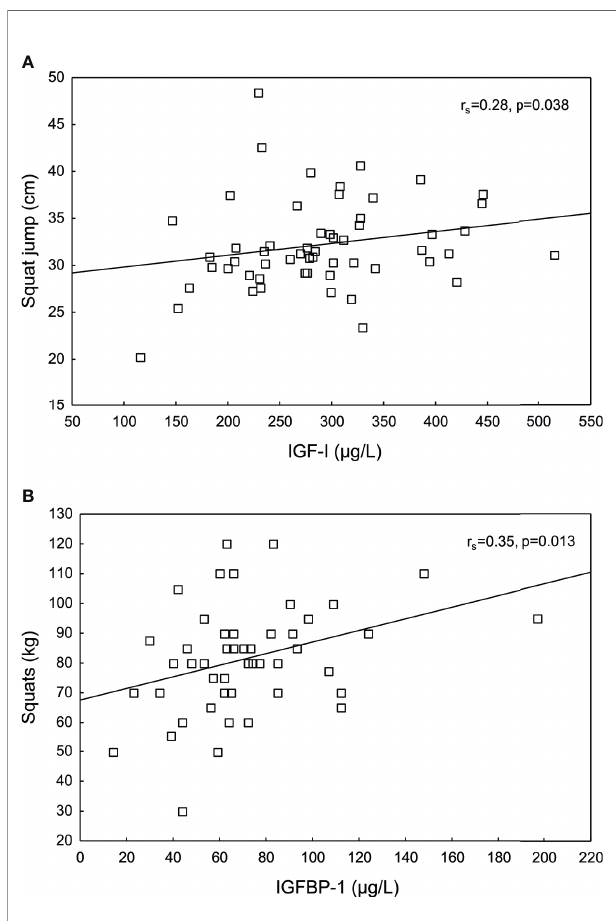
FIGURE 4 | Signi fi cant positive correlations between (A) insulin-like growth factor I (IGF-I) and squat jump (SJ), and between (B) IGF binding protein 1 (IGFBP-1) and squats in female Olympic